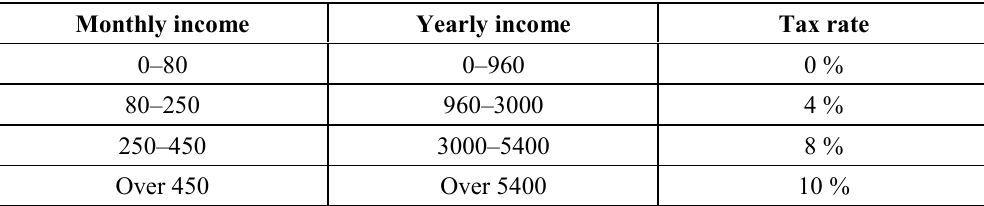
Table 2. Tax Rates by Public